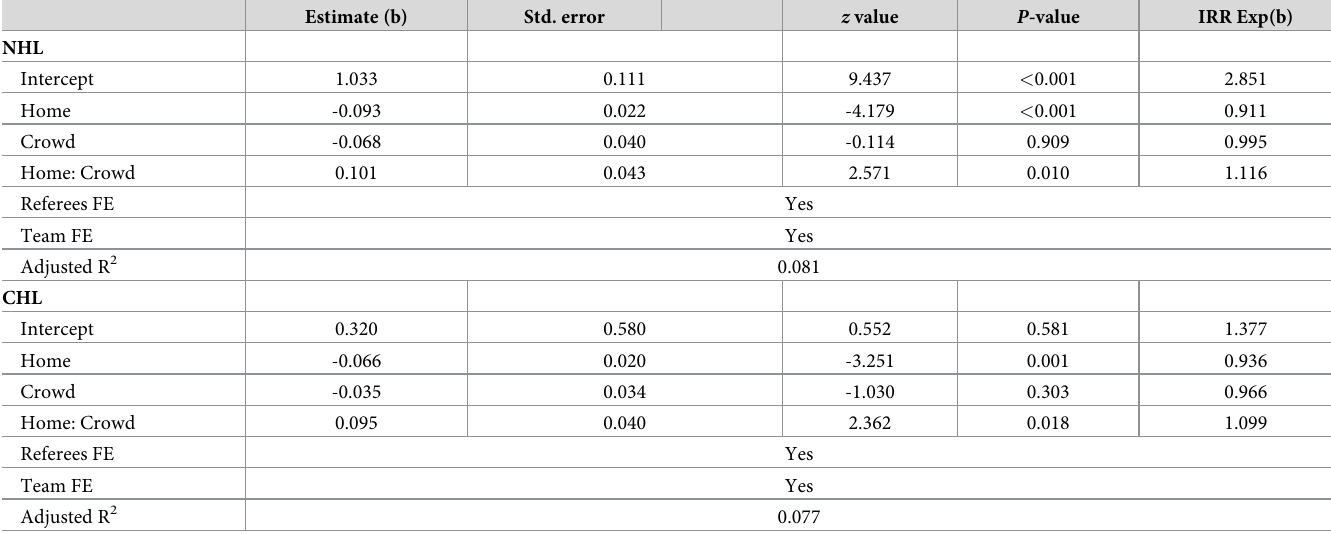
Table 5. Estimated regression parameters for NHL ( n = 3278) and CHL ( n = 3418) regular seasons Poisson